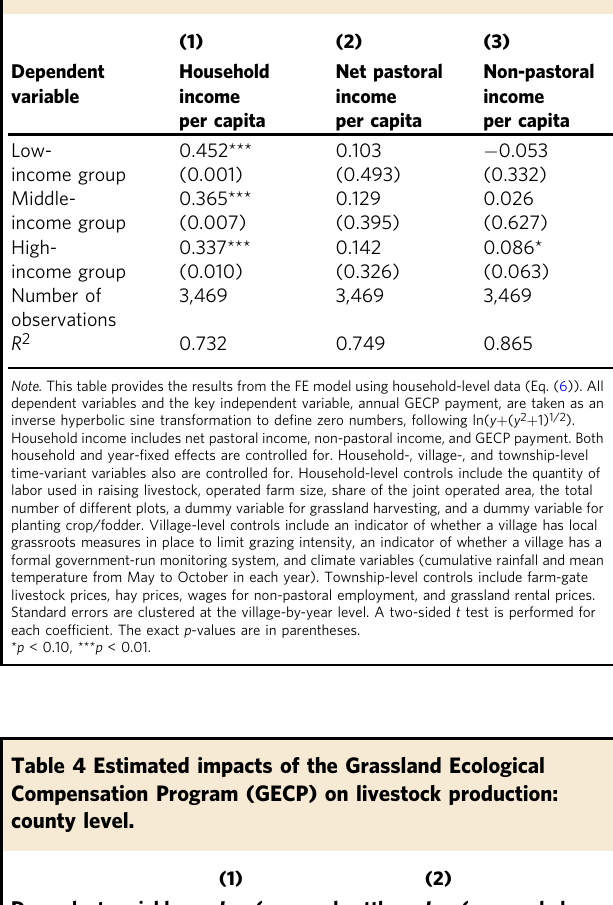
Table 2 Estimated impacts of the Grassland Ecological Compensation Program (GECP) on herder income: household level, FE model.